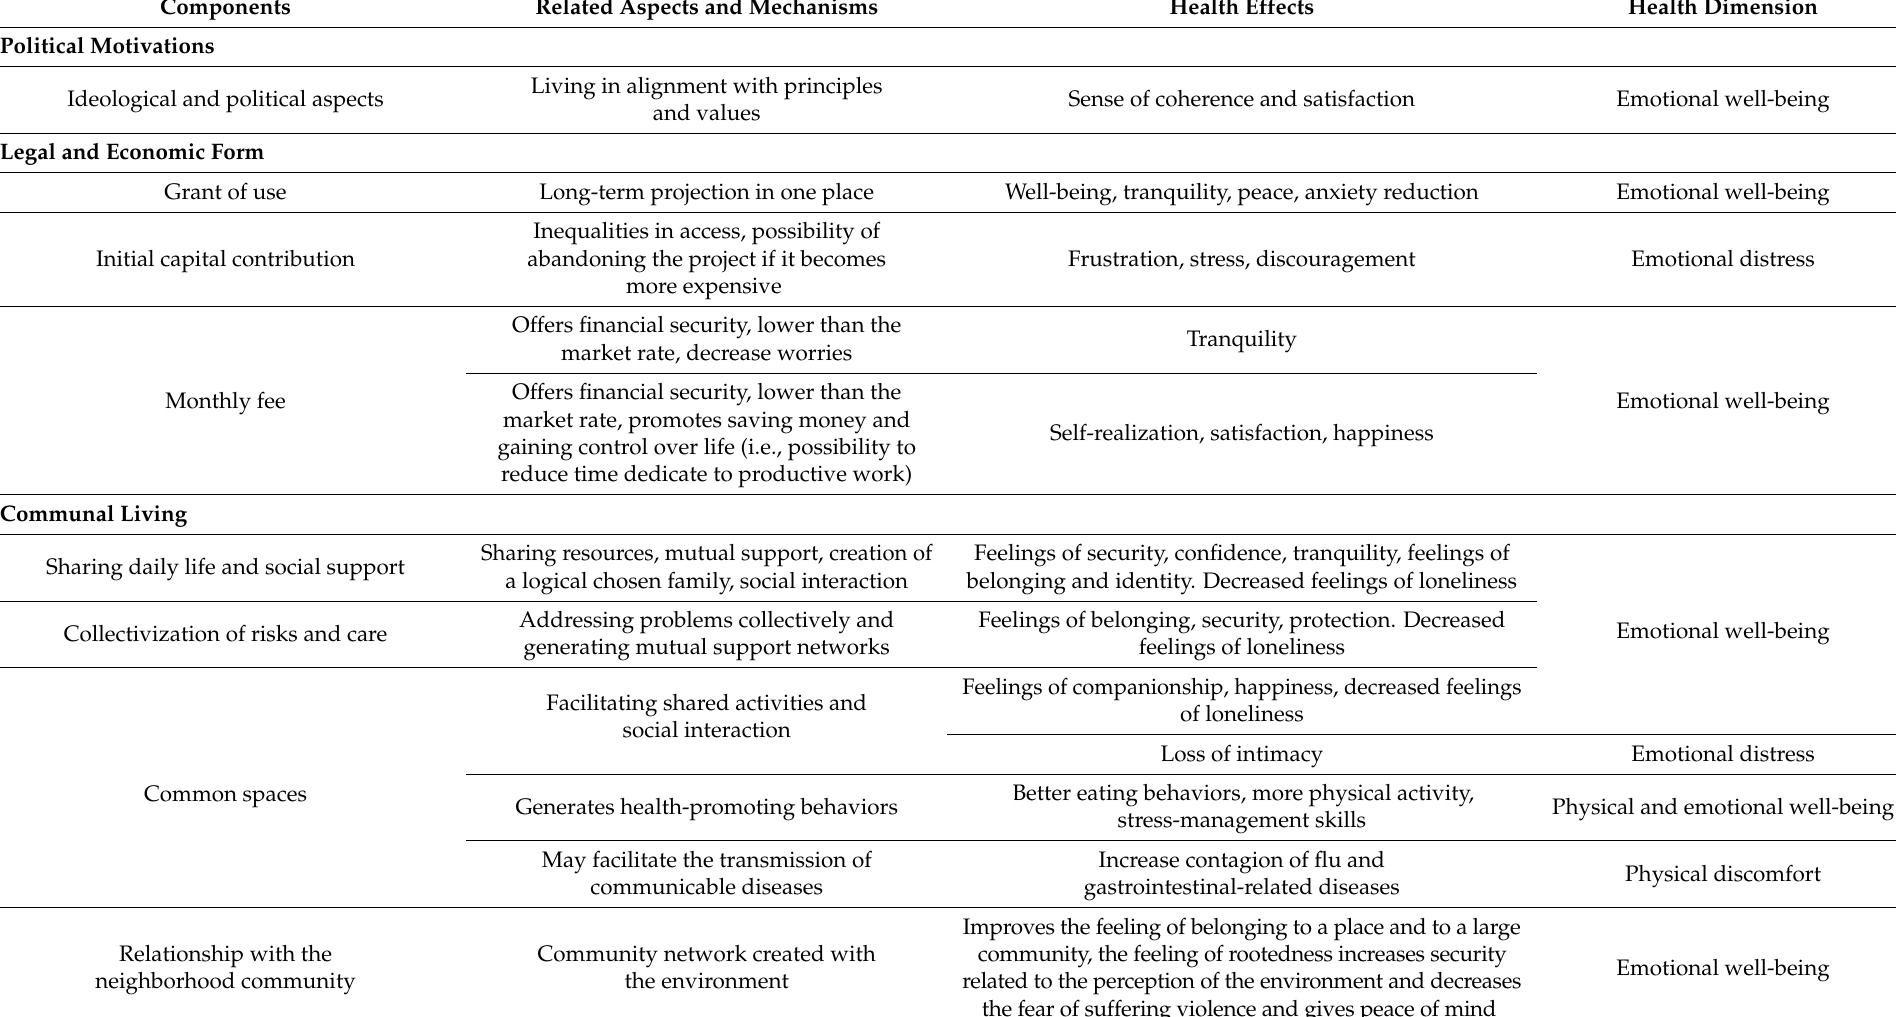
Table 3. Summary of the main results (elaborated by the authors